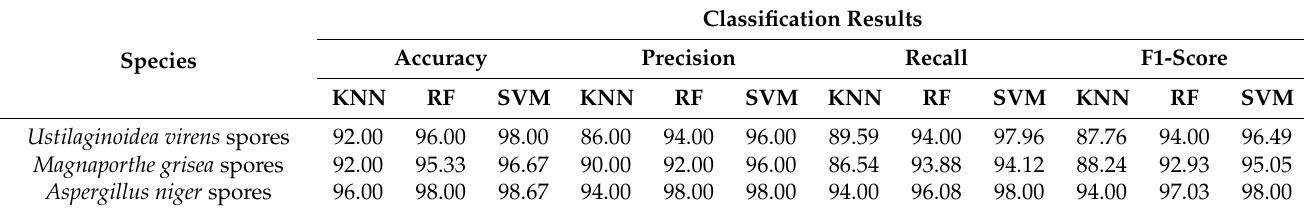
Table 1. Classification results of different classification models.